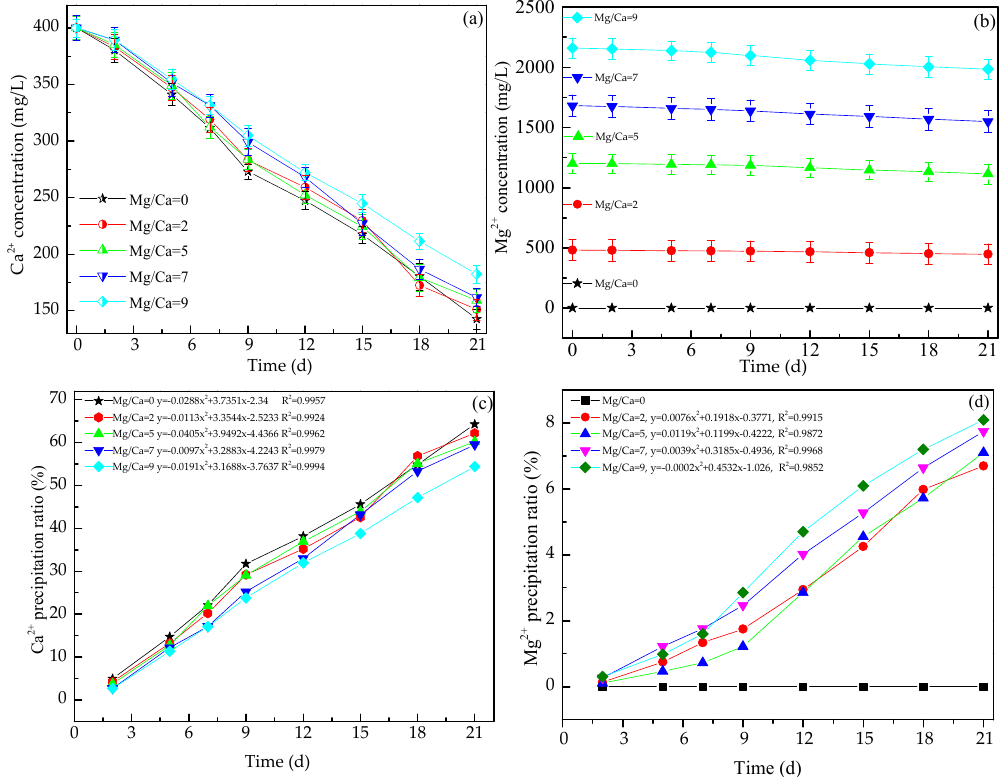
Figure 4. Changes of Ca 2+ concentration ( a ), Mg 2+ concentration ( b ), Ca 2+ precipitation ratio ( c ), and Mg 2+ precipitation ratio ( d ).